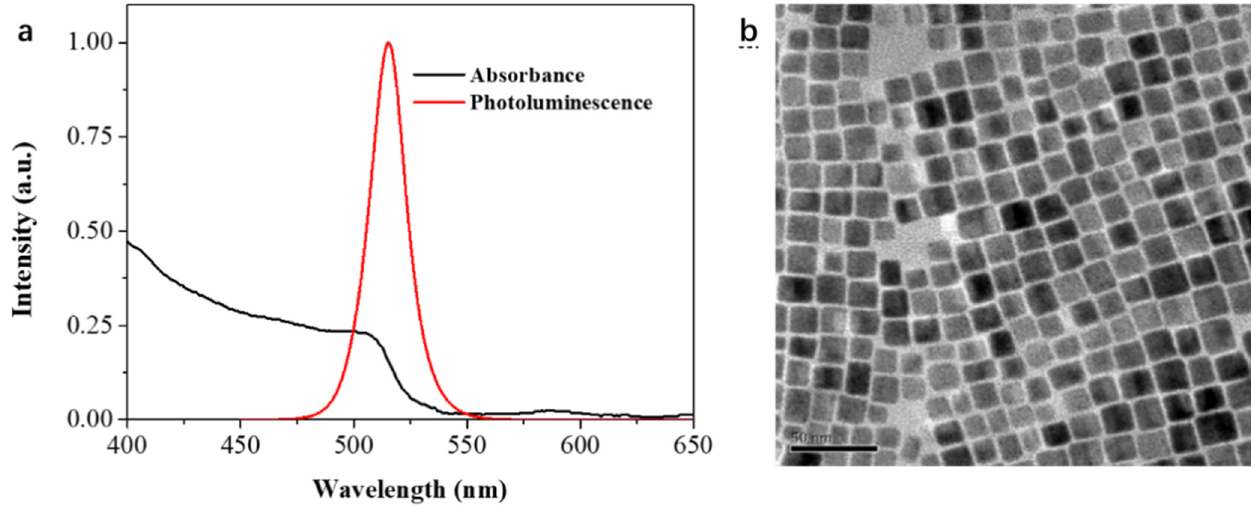
Figure 2. Absorbance and fluorescence spectra of the synthesized CsPbBr 3 PNCs ( a ) and their TEM images ( b ).